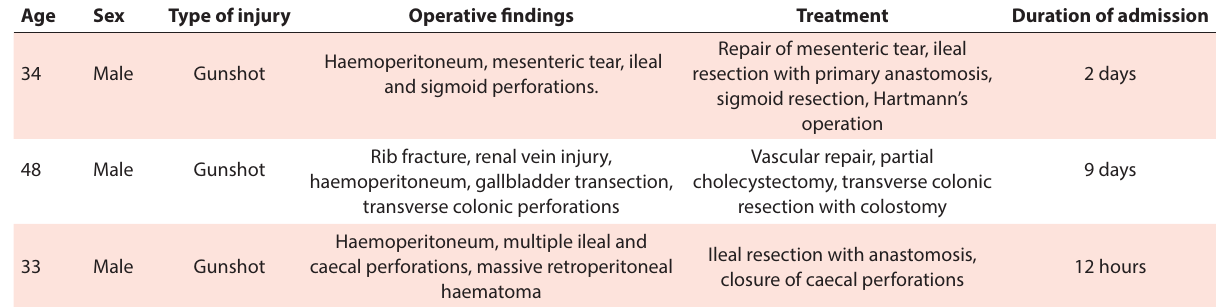
Table 4. Disposition of mortality